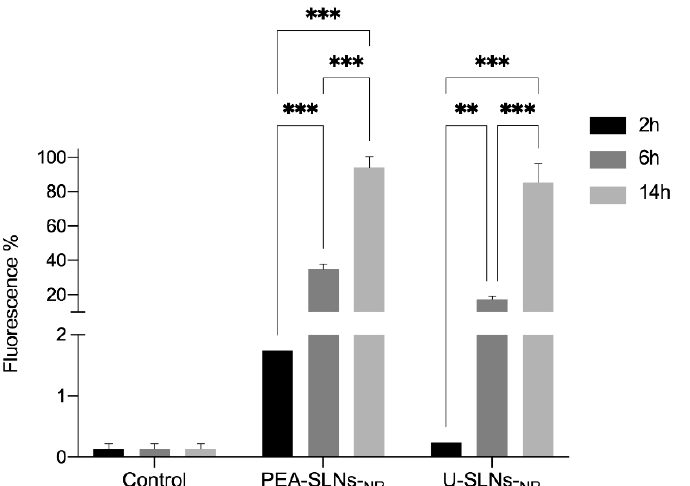
Figure 6. Flow cytometric analysis of C2C12 cells after 2, 6, and 14 h incubation with PEA-SLNs-NR and U-SLNs-NR in comparison with untreated cells (control). For the points at 2 h, error lines do not exceed bar size. Statistical significance levels are indicated as: ** ( p < 0.02); *** ( p < 0.01).